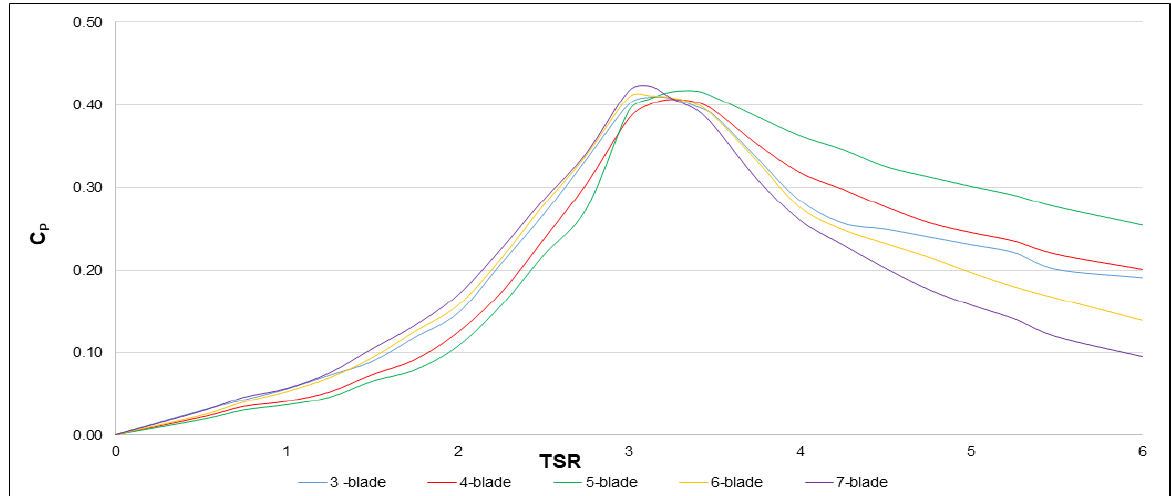
Figure 6. Coefficient of power vs. TSR plot for the different number of blades.